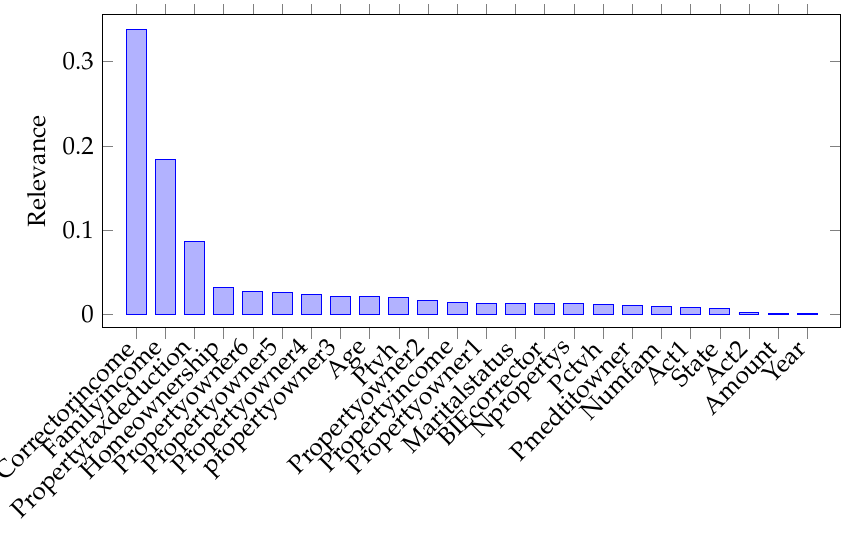
Figure 3. Results of the gain ratio for the IEF